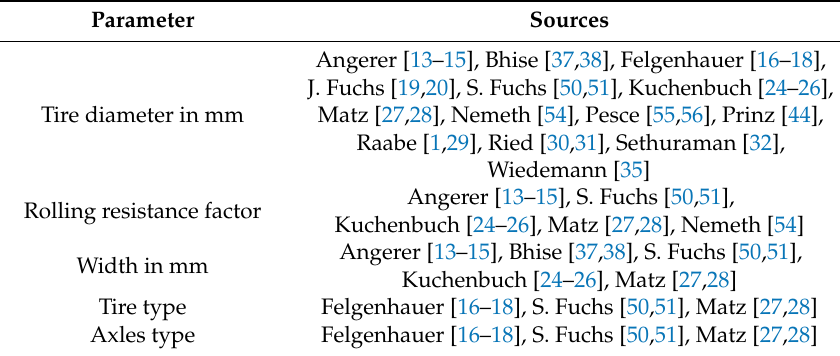
Table 7. Overview of the design parameters for the tires and axles.